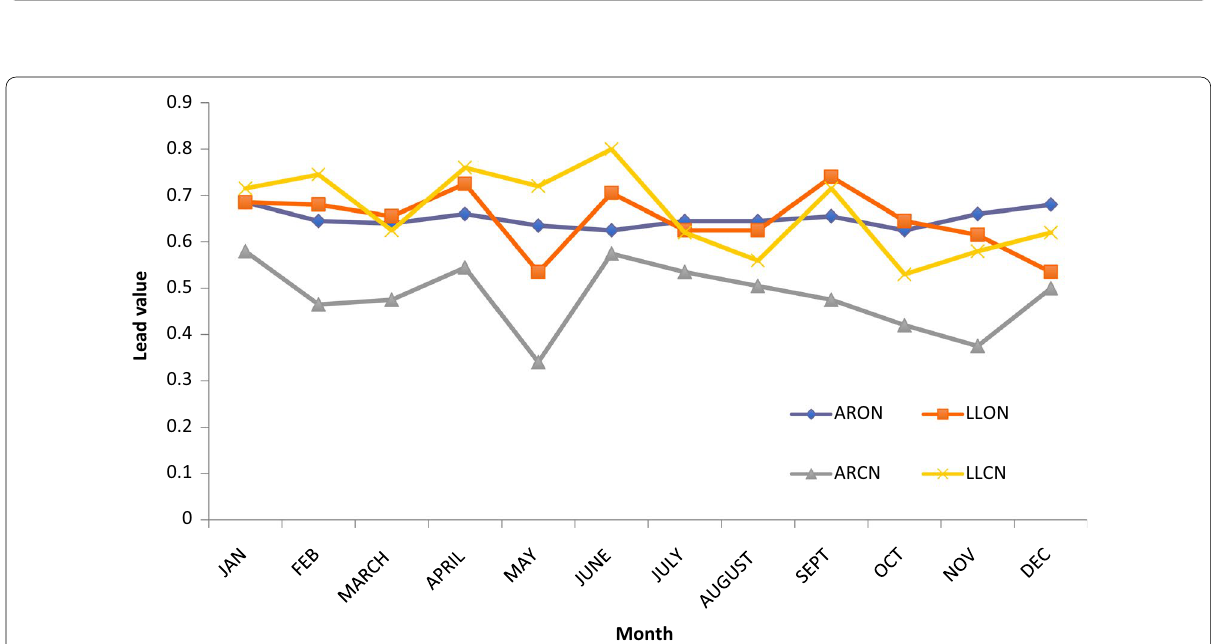
Fig. 7 Mean Comparative Lead (Pb) concentration among C. nigrodigitatus and O. niloticus species collected from Asejire Reservoir and Lagos